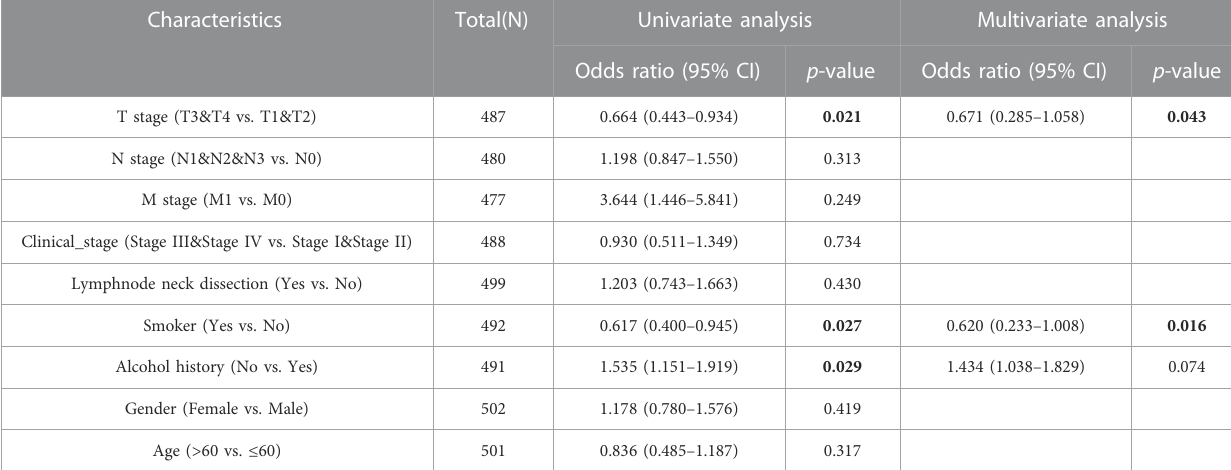
TABLE 4 Logistic analysis of associations between GSTK1 expression and clinical characteristics.